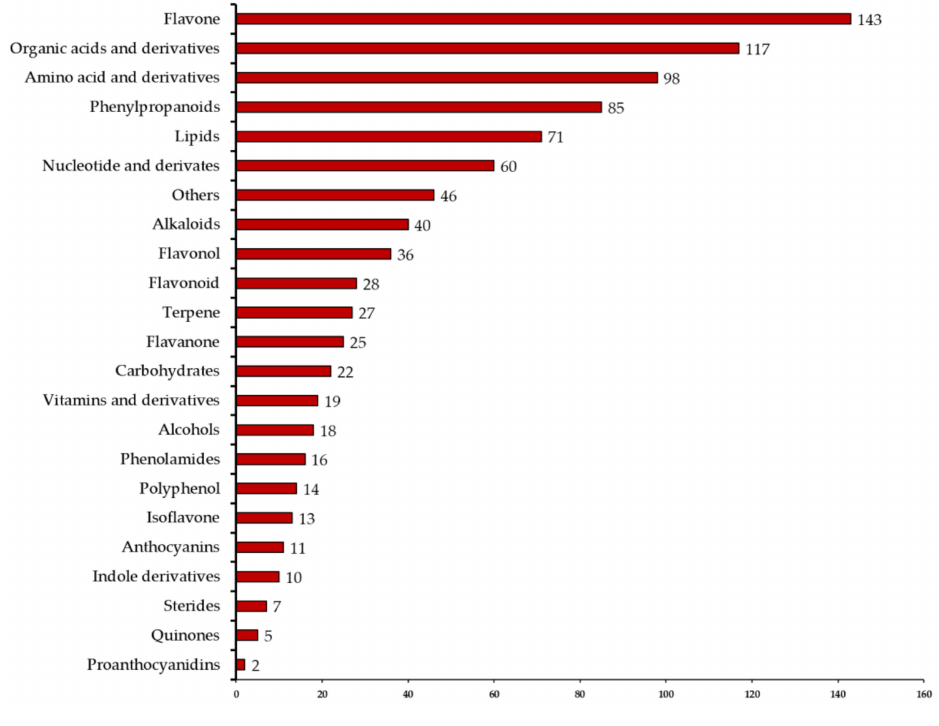
Figure 2. Number of di ff erent types of metabolites identified in all samples.